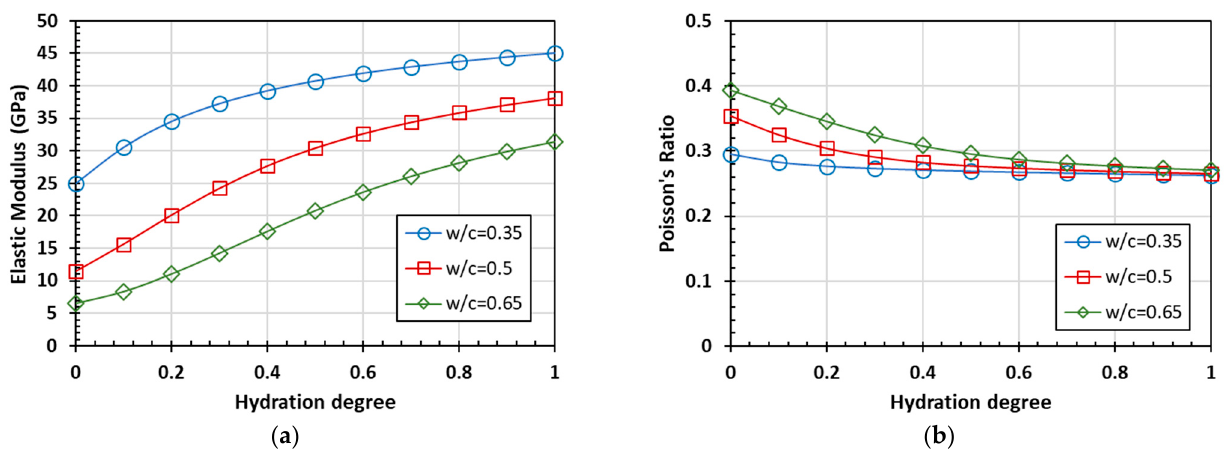
Figure 8. The predicted elastic parameters of concrete as functions of the hydration degree: ( a ) elastic modulus and ( b ) Poisson’s ratio.